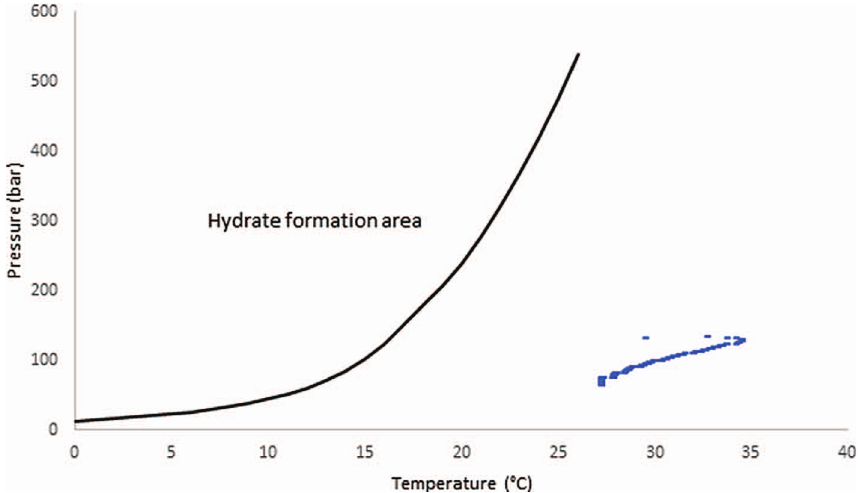
Fig. 6. Hydrate risk prevention: hydrate formation stability curve (black line) – Estimate temperature and pressure at the wellhead during a withdrawal (blue